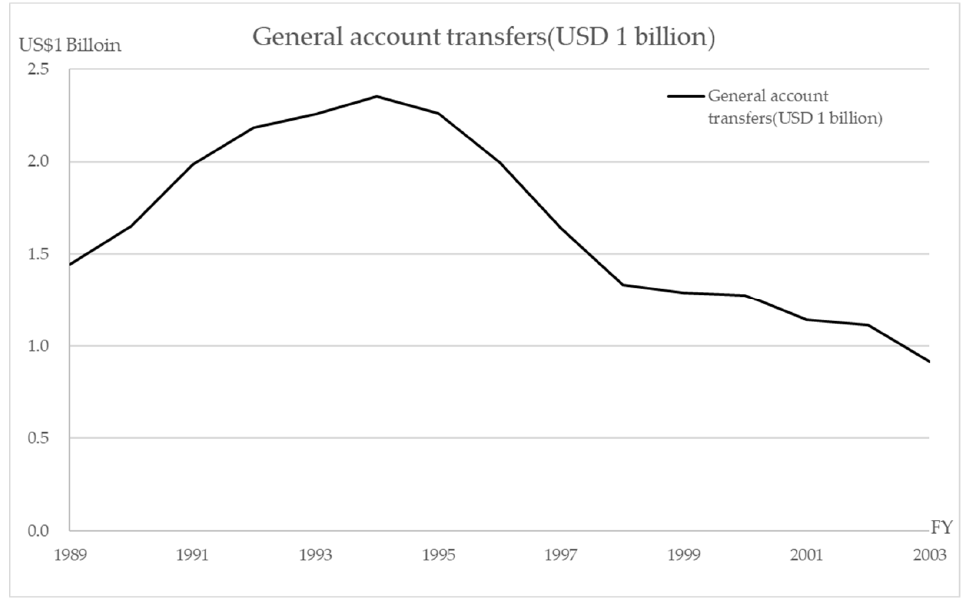
Figure 1. General account transfers (USD 1 billion).